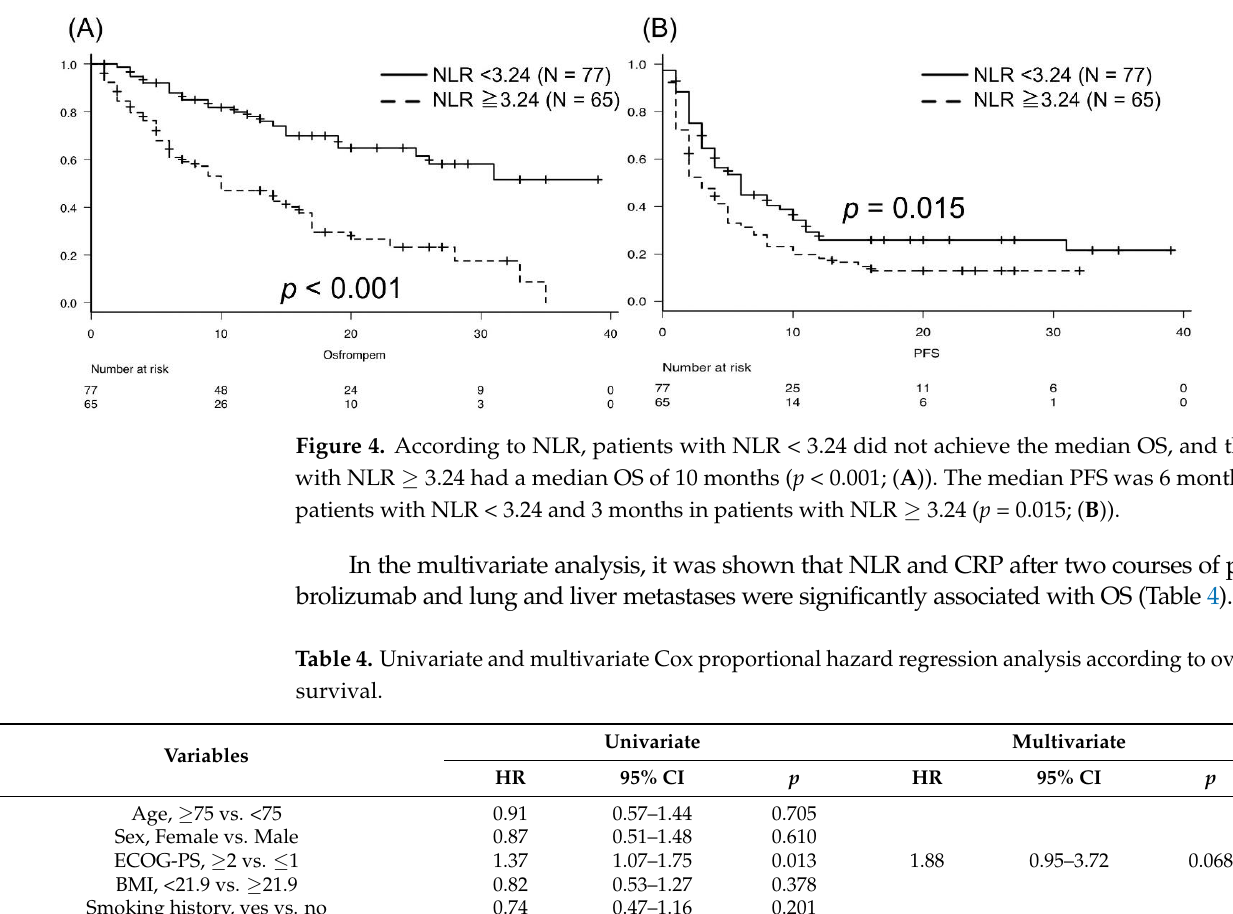
Table 4. Univariate and multivariate Cox proportional hazard regression analysis according to over- all survival.